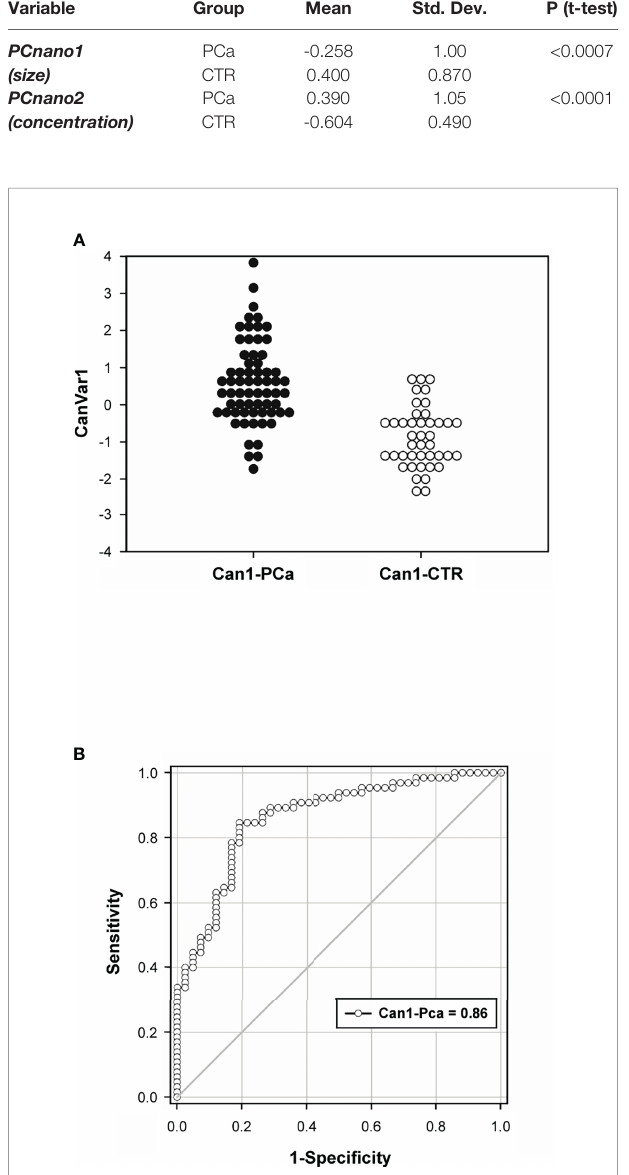
FIGURE 5 | Canonical Variate distribution (CanVar1) (A) and Receiving Operating Characteristics (ROC) curve (B) relative to cancer-healthy discrimination based on CanVar1.